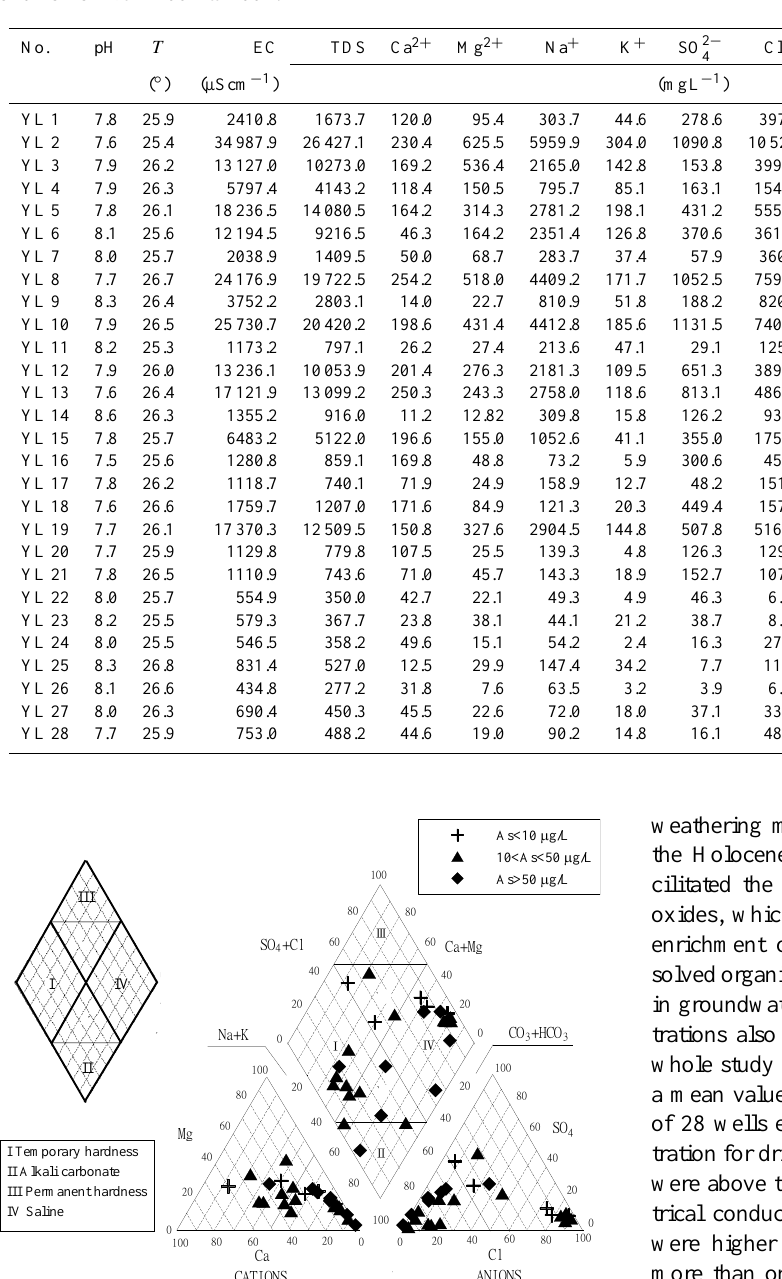
Table 1. Mean values of hydrogeochemical compositions of groundwater among monitoring wells in the coastal area of the Choushui River alluvial fan from 1992 to 2004.